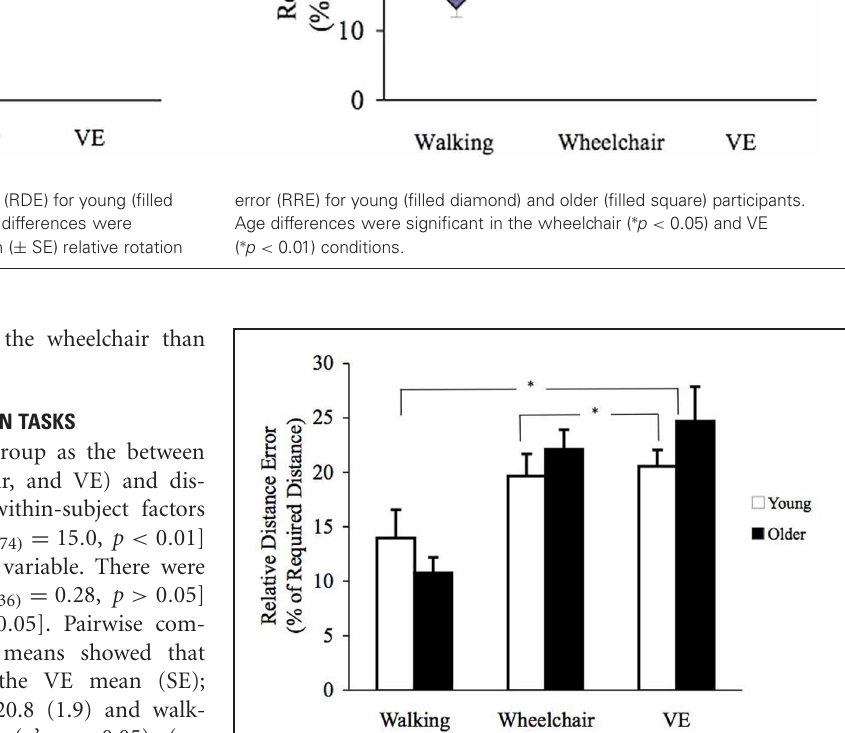
FIGURE 3 | Mean ( ± SE) relative distance error (RDE) for young (open) and older (filled) participants. Conditions differences were found between VE and wheelchair; VE and walking conditions ( ∗ p ’s <